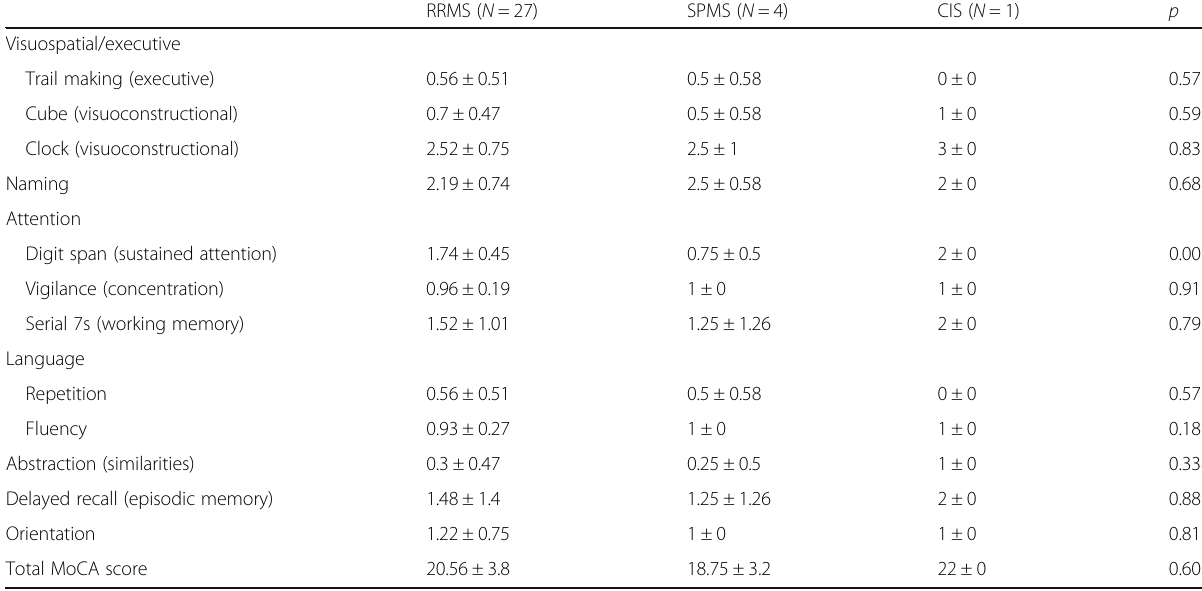
Table 5 Montreal cognitive assessment in MS subtypes with cognitive impairment